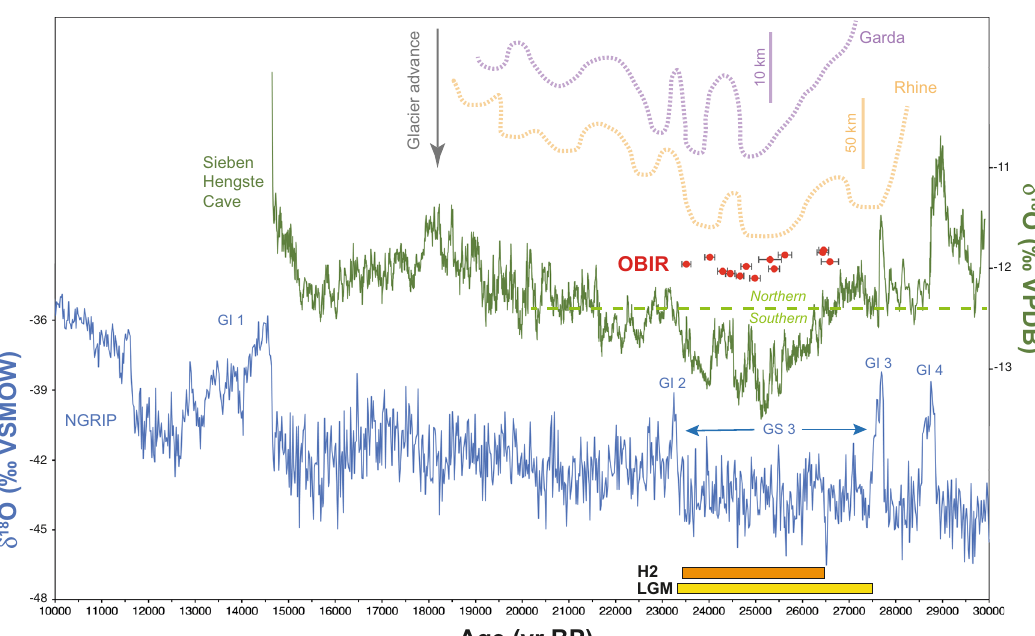
Fig. 5 Ages of cryogenic cave carbonates from the Obir caves compared with key records for the Last Glacial Maximum. Cryogenic cave carbonates data (red, with two sigma error bars), oxygen isotope records from the North Greenland Ice Core Project (NGRIP 2 ) and Sieben Hengste cave 16 and the reconstructed extent of the Rhine and Garda paleoglaciers 9 . The green dashed line separates dominantly southern (i.e., Mediterranean-sourced) and northern/northwestern (i.e., Atlantic-derived) trajectories according to ref. 16 . The yellow and orange bars at the bottom indicate the global Last Glacial Maximum (LGM) 1 and the timing of Heinrich event (H) 2 35 – 37 , respectively. Selected Greenland Interstadials (GI) and Stadials (GS) are labeled. Note that the cryogenic cave carbonate data have no y-variability and that the offsets are only for